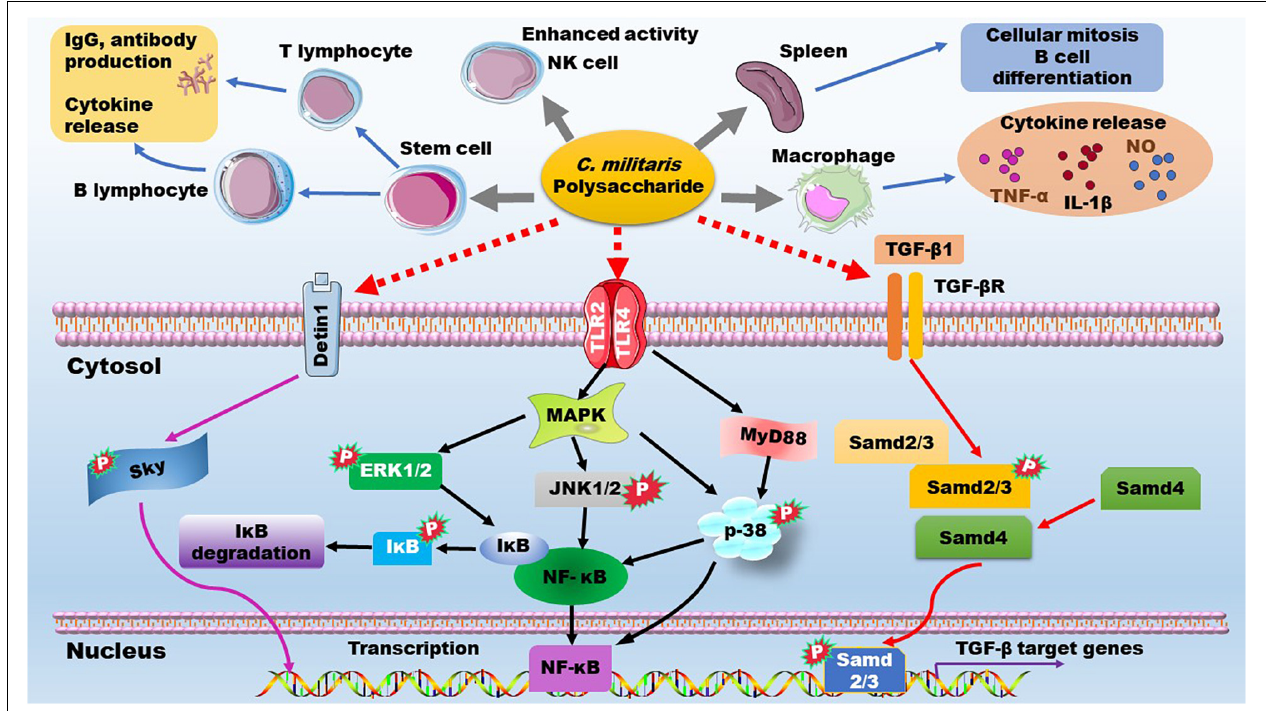
FIGURE 8 | The immune enhancement effects and the underlying mechanisms of C. militaris -derived polysaccharides. ERK, extracellular regulated kinase; IgG, immunoglobulin G; IL, interleukin; JNK, C-Jun Kinase; MAPK, mitogen-activated protein kinase; NF- κ B, nuclear factor kappa-B; NK cell, natural killer cell; NO, nitric oxide; PRRs, pattern recognition receptors; TGF- β , transforming growth factor β ; TGF- β R, TGR- β receptor; TLR, Toll-like receptor; TNF- α , tumor necrosis factor- α